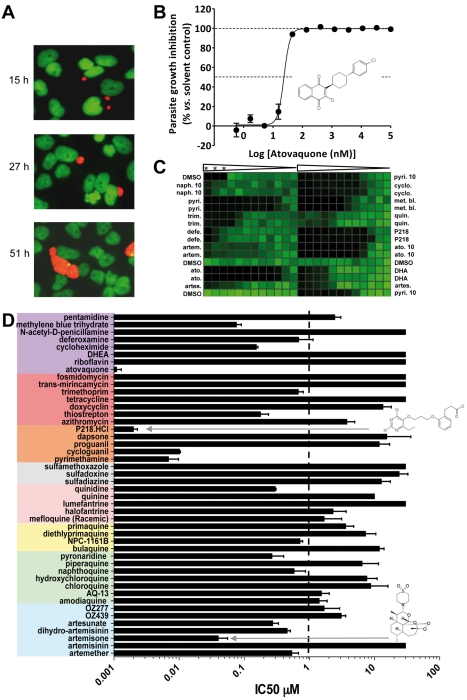
Validation and results of anti-infectives tested against P. yoelii liver stage parasites.(A) Opera-generated images from a time point experiment using a 20× objective lens. P. yoelii parasites (red) were visualized using a mouse polyclonal HSP70 antibody, and the HepG2 cells (green) were stained with Hoechst 33342 nucleic acid dye. Median parasite areas for the 15-h, 27-h, and 51-h time points were calculated as 16, 52, and 158 µm2, respectively, using a custom Acapella script. (B) A dose response plot with atovaquone from data generated from the Opera imaging system. The median areas of compound-treated parasites were compared to untreated DMSO controls to determine the degree of inhibition. The IC50 value of atovaquone is 22 nM. (C) From the Acumen eX3 imaging system, a 384-well heat map plate image of P.yoelii fluorescence intensities from a dose response experiment with the most active anti-infectives. The three wells at the top left corner were not infected with sporozoites and served as a negative control. Wells were treated with a 1∶3 dilution of compounds starting at 30 µM (0.1% DMSO). In the experiments where the highest compound concentration tested was 10 µM, the entry is labelled 10. Compounds used are: naphthoquine (naph.), pyrimethamine (pyri.), trimethoprim (trim.), deferoxamine (defe.), artemisone (artem.), atovaquone (ato.), artesunate (artes.), cycloguanil (cyclo.), methylene blue (met. bl.), quinidine (quin.), dihydroartemisinin (DHA). Triangles represent the dilution steps of the drugs as described above. Stars designate the three wells with no sporozoite. (D) IC50 results from a compound dose response experiment performed in a 384-well plate format. Results were generated from the Opera using median parasite area to determine level of inhibition.